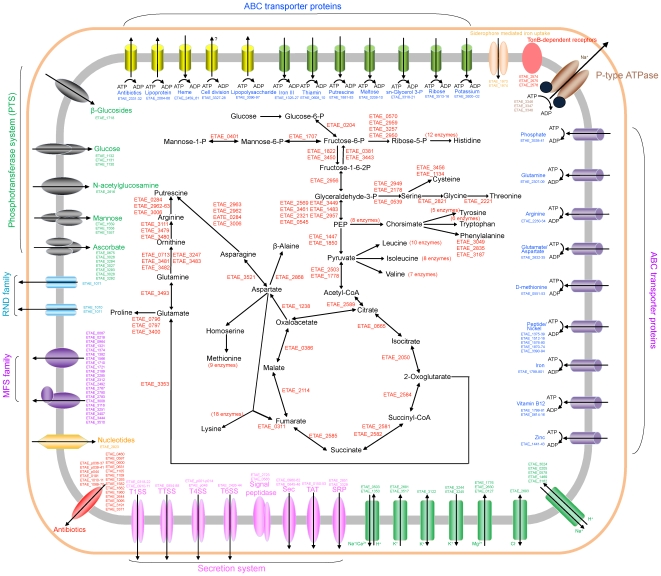
Overview of metabolism and transport in EIB202.Different transport families are distinguished by different colors and shapes. From top left going clockwise: ABC-2 and other transporters (yellow); phosphate and amino acid transporters (green); Siderophore-iron (III) receptors (brick red); TonB-dependent receptors (rosybrown); P-type ATPase (chocolate); mineral and organic ion transporters (violet); ion efflux (green); secretion systems (pink); drug/metabolite efflux (red); nucleotides transporters (orange); the major facilitator superfamily (MFS) (purple); the resistance-nodulation-cell division family (RND) (blue); phosphotransferase system (PTS) (black). Arrows indicate the direction of transport. All the amino acid biosynthesis genes are listed in Table S2.